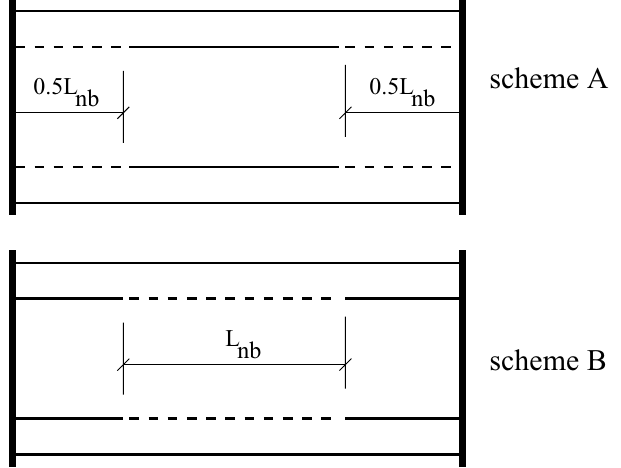
Fig. 2. Schematic drawing for the partially-bonded interfaces (Notice that 0 (cid:1) L nb (cid:1) L varies as a fraction of the total panel length L , for both schemes A and B . Results of parametric studies are shown in Fig. 21).